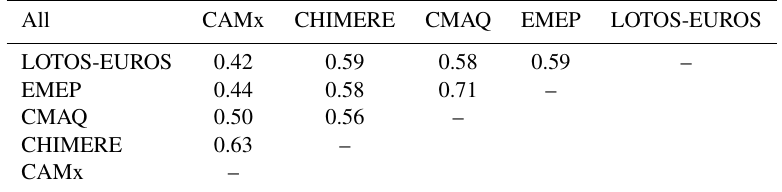
Table 6. Correlation between models for the whole domain (all grid cells) based on hourly data for O 3 total concentration.